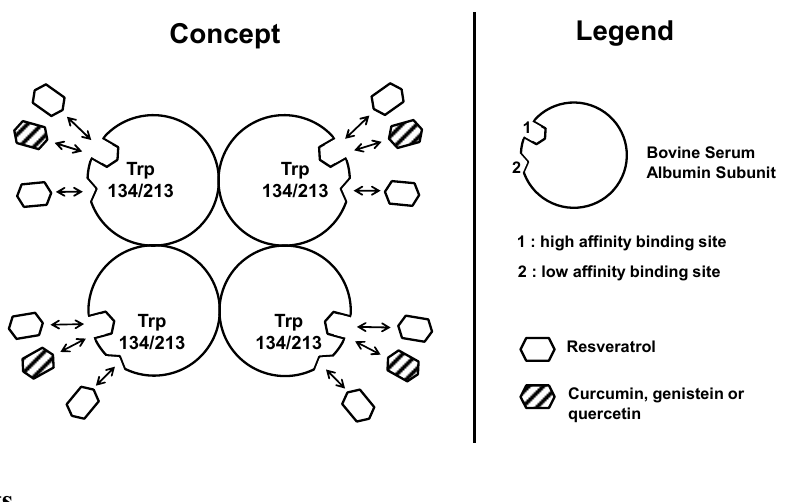
Figure 3. Proposed competitive interaction between resveratrol and other dietary polyphenols toward albumin. Consequences for their